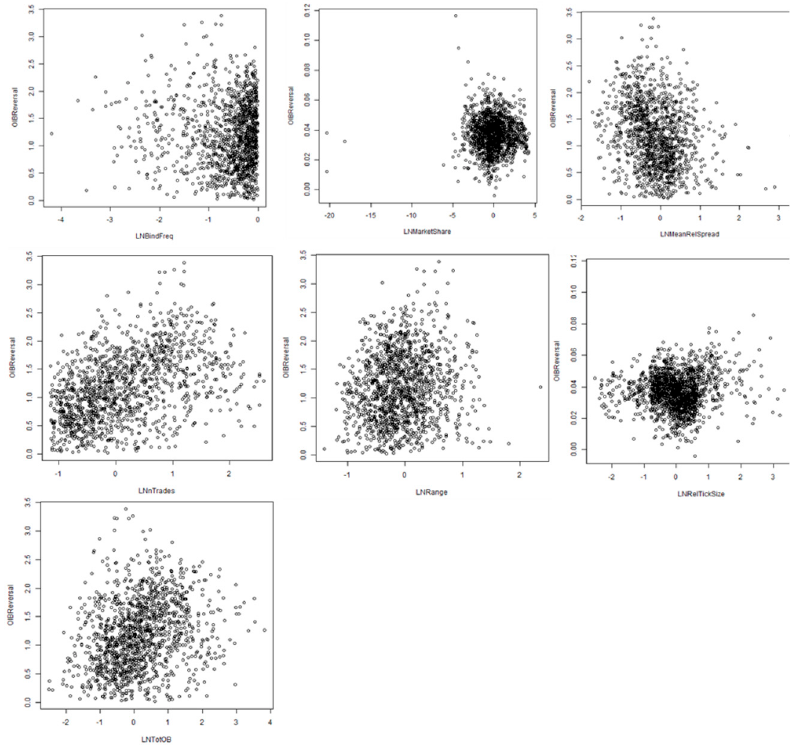
Figure 1. Log–log scatter plots of independent variables ( X -axis) and dependent variable OIB-reversal.